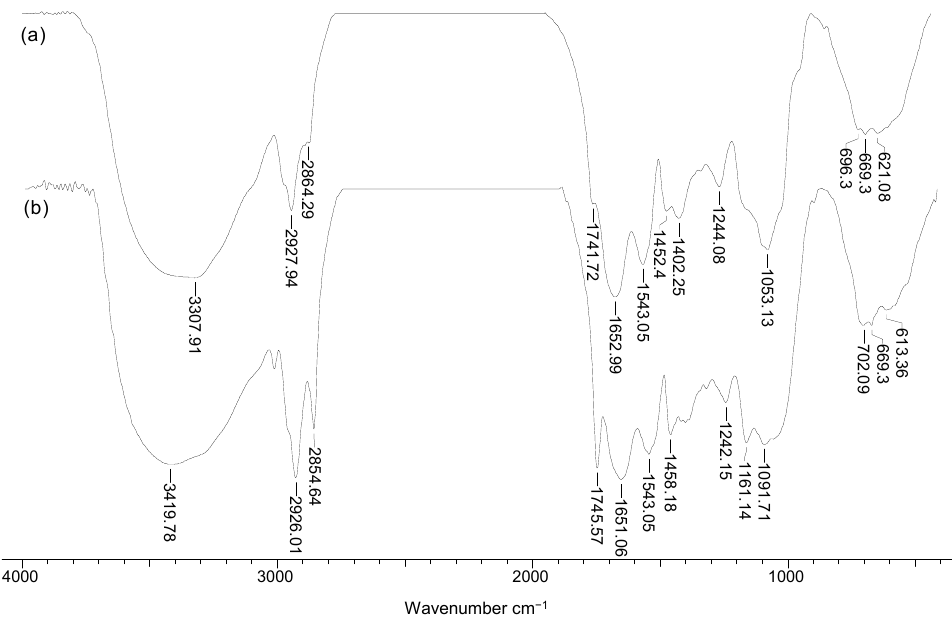
Figure 1. FTIR spectra of soy waste biomass before ( a ) and after ( b ) alkaline treatment. The increased intensity of these absorption bands suggests that, on the surface of Na- SW, the number of available functional groups was higher compared with SW biomass. In addition, the shift of absorption bands to higher wavelengths indicates that these functional groups had more degrees of freedom, probably due to the breakage of physical (hydrogen) bonds, thus facilitating interaction with metal ions in aqueous